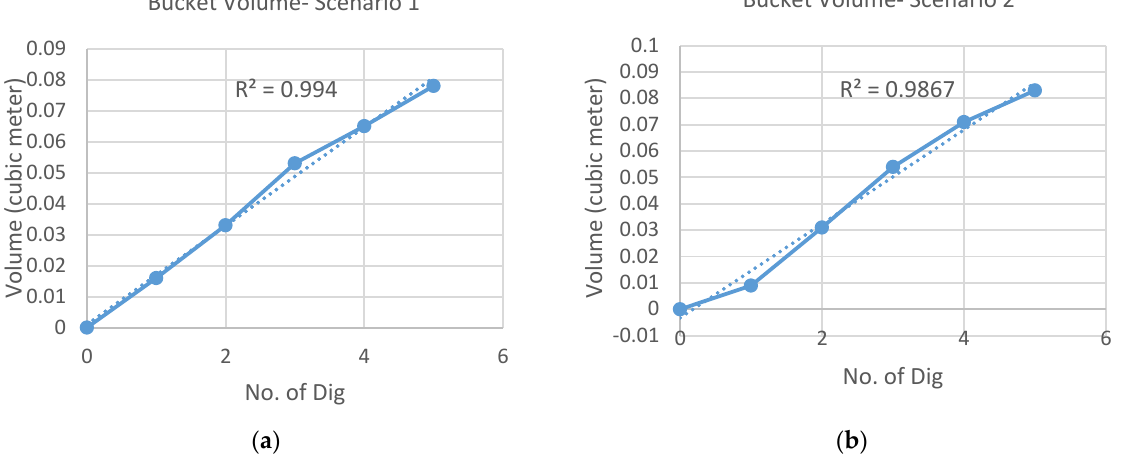
Figure 14. Results of bucket volume estimation: ( a ) Scenario 1; ( b ) Scenario 2.